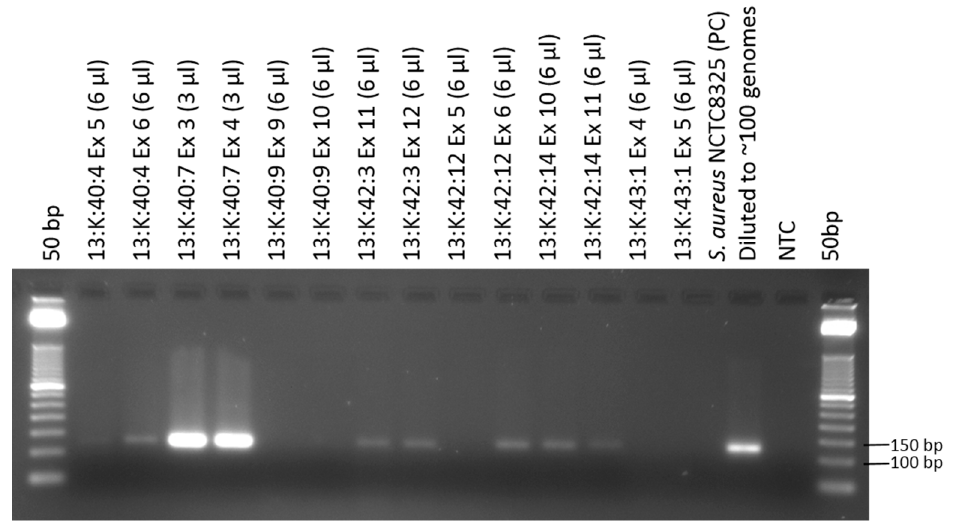
Figure 2. Results of the PCR-based detection of S. aureus specific 122 bp nuc sequences after agarose gel electrophoresis (DNA inset bracketed). Gel bands are located between the 100 bp and 150 bp fragments of the DNA ladder, indicating that the sought amplification product of 122 bp was generated. 9/14 amplifications resulted in visible bands; the negative template control (NTC) shows no evidence of pathogenic DNA presence in the PCR reaction mix. As a positive control, DNA of the strain NCTC8325 (approximately 100 genomes) was used. Electrophoresis parameters: 8 µL PCR product with 2 µL loading dye, 4 µL size standard: 50 bp DNA ladder (Invitrogen™, Carlsbad, CA, USA), 2.5% gel, 120 V, exposure time: 1.00 s. For detailed description of the extract nomenclature see Supplementary Text, Table S1.